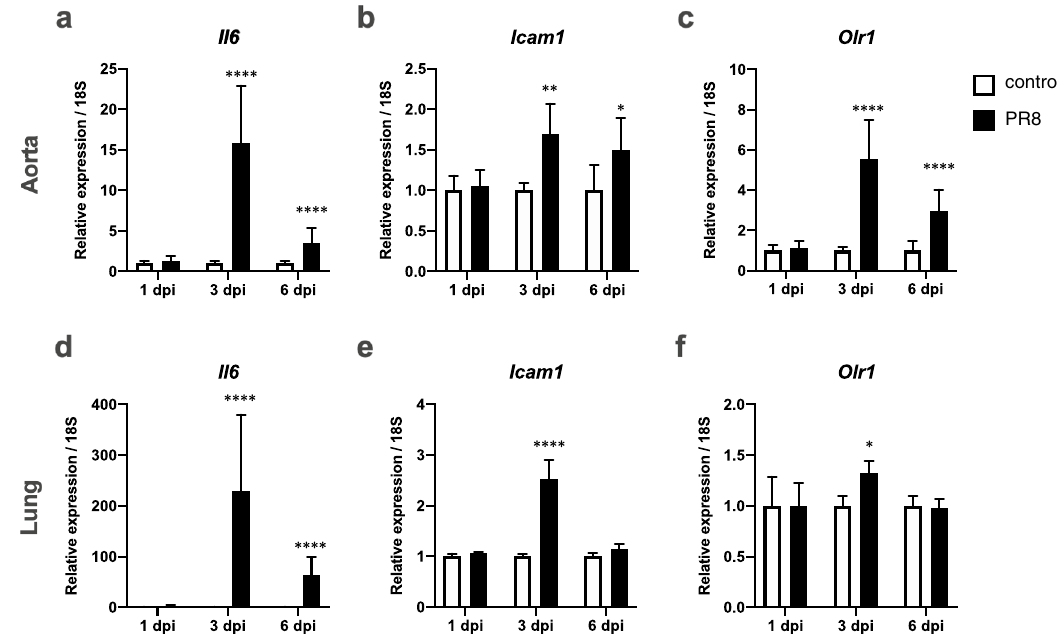
Figure 2. Expression of inflammation-related genes in the aorta and lungs. Mice were intranasally inoculated with PBS control or PBS comprising PR8 virus, and ( a–c ) aortic and ( d–f ) lung samples were collected at 1, 3, and 6 dpi. ( a and d ) Il6 , ( b and e ) Icam1 , and ( c and f ) Olr1 gene expression was normalized with that of 18S from real-time PCR analyses. ( a–f ) Gene expression of PR8 virus-infected mice is presented as the fold changes relative to those of control mice at each time point. Bars represent the mean ± SEM of 11(PR8-3 dpi and PR8-6 dpi groups) or 12 (the other groups) animals for aorta and 4 animals for lung, respectively. White and black bars indicate data from control and PR8 virus-infected mice, respectively. * p < 0.05, ** p < 0.01, **** p < 0.0001, two-way ANOVA using a multiple-comparison correction, control versus PR8 virus-infected mice at each time point. PR8, influenza virus A/Puerto Rico/8/34; dpi, days